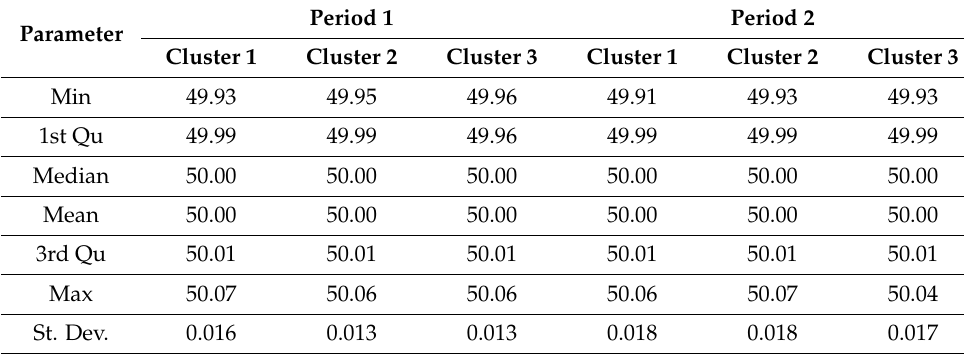
Table 3. Descriptive statistics of the frequency at the tested measuring point.